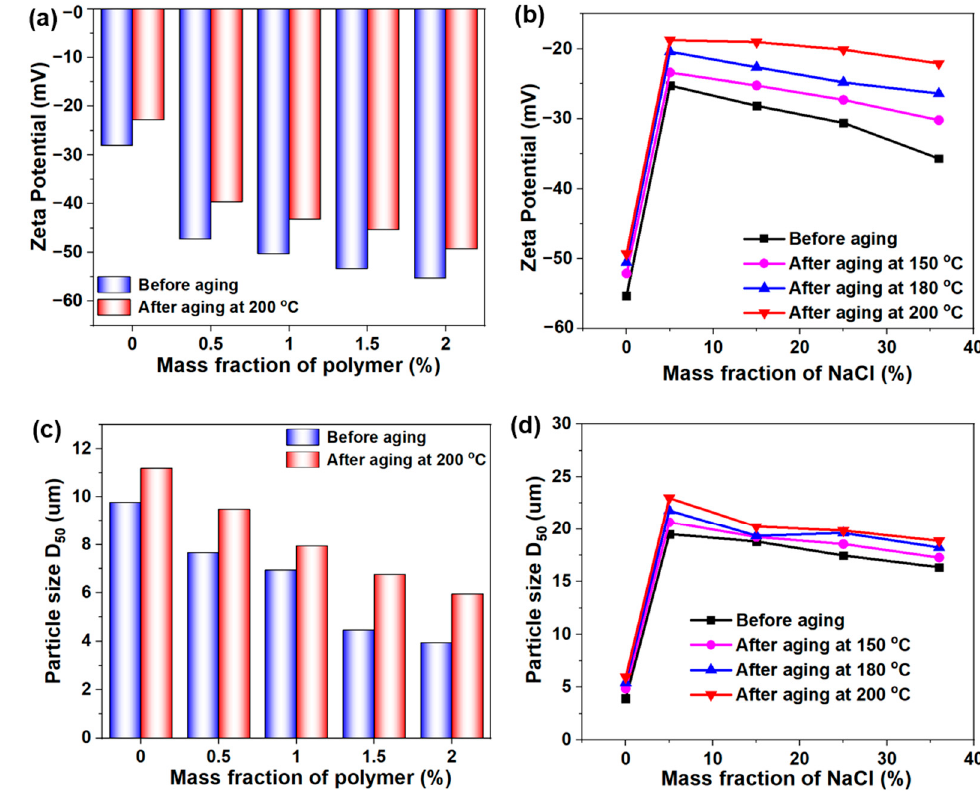
Figure 7. ( a ) Zeta potential curves of DDAM-based drilling fluid before aging and after aging at 200 °C. ( b ) Zeta potential curves of 2 wt% DDAM-based drilling fluid with different fraction of NaCl before aging and after aging at 200 °C. ( c ) Particle size of DDAM-based drilling fluid before aging and after aging at 200 °C. ( d ) Particle size of 2 wt% DDAM-based drilling fluid with different fraction of NaCl before aging and after aging at 200 °C.